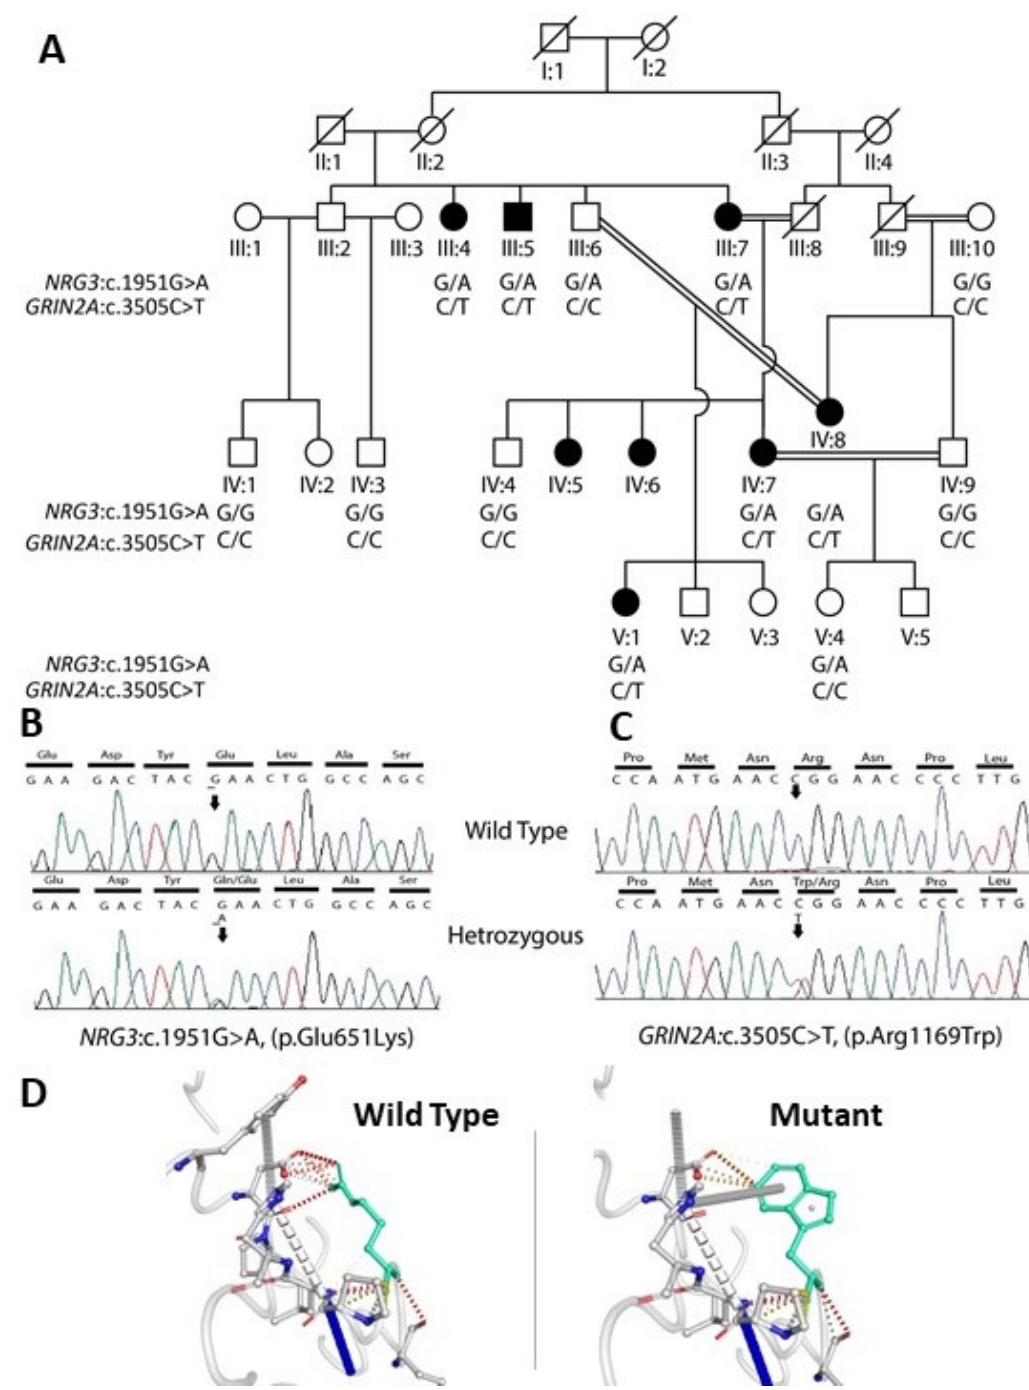
Figure 2. Pedigree and genetic analysis of family B: ( A ) Pedigree of five generations of consanguineous Pakistani family with eight affected individuals (filled symbols), the C/C and G/G represent the wild-type genotype for c.3505C>T and c.1951G>A variants, respectively, which are replaced with C/T and G/A genotype in affected individuals. ( B ) Sequence chromatogram representing NRG3 variant c. 1951G>A. ( C ) Sequence chromatogram showing part of the GRIN2A gene carrying the c.3505C>T variant in wild-type ( top ) and affected individuals ( bottom ). ( D ) iTASSER prediction revealed that the mutation GRIN2A: p.R1169W destabilized the whole structure with increased flexibility of the mutant